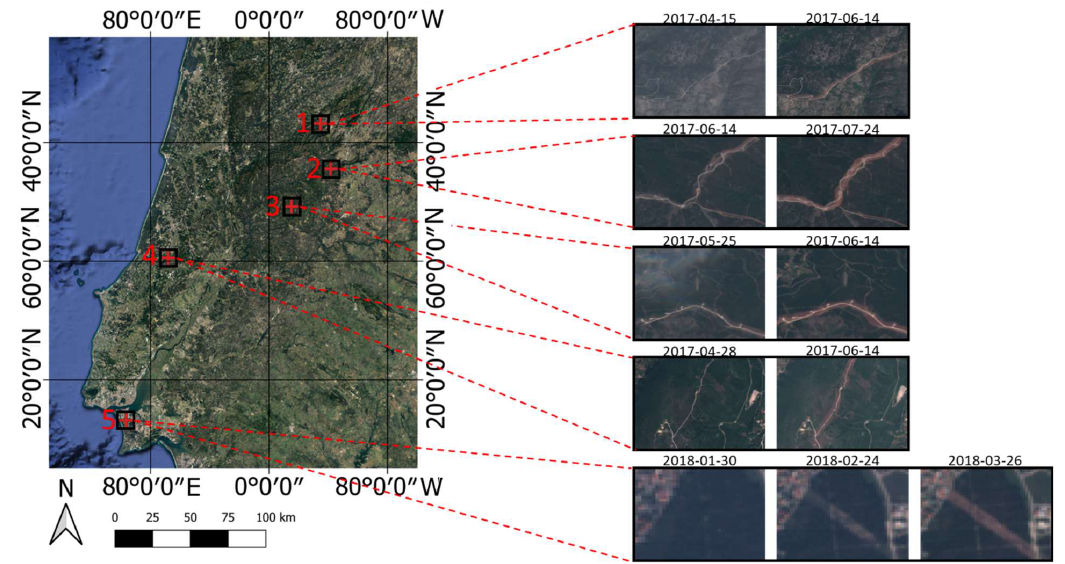
Figure 14. TCI observations before and after maintenance operations. 1-Seia; 2-Fundão; 3-Sertã; 4- Serra dos Candeeiros; 5-Marisol.